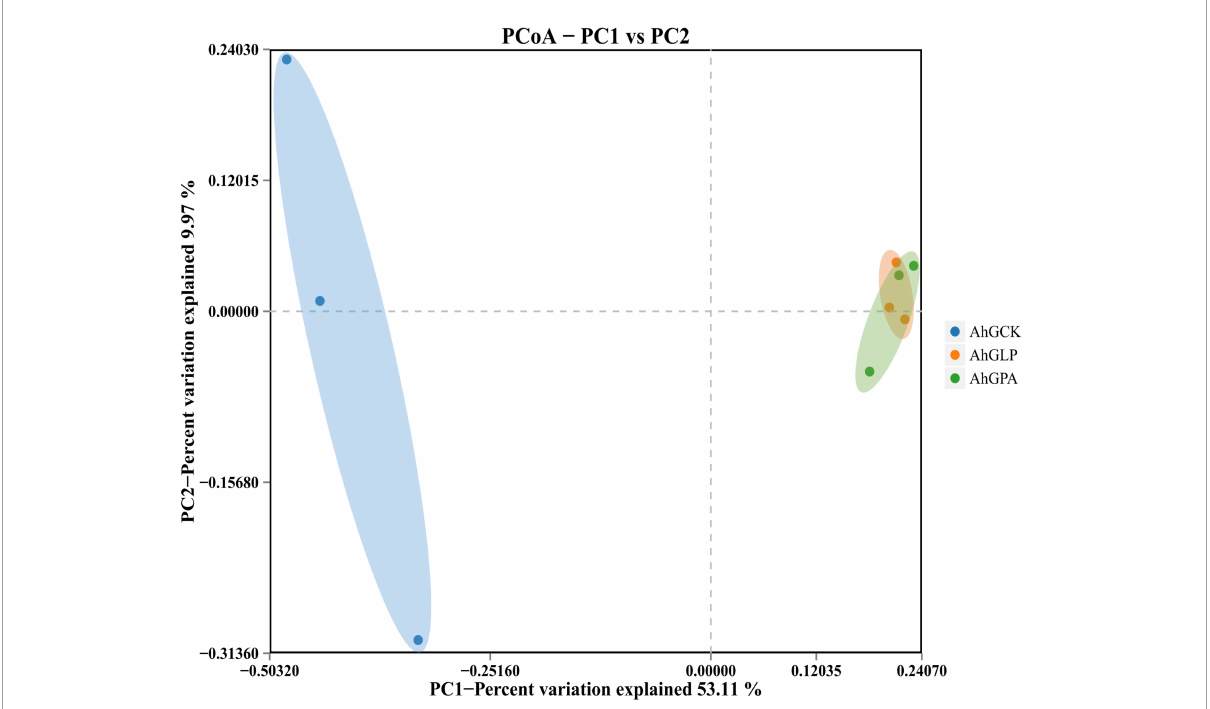
FIGURE1 Bacterial β -diversity of high-moisture amaranth silage with Lactobacillus plantarum and propionic acid additives. AhGCK, control; AhGLP, L. plantarum ; AhGPA, propionic